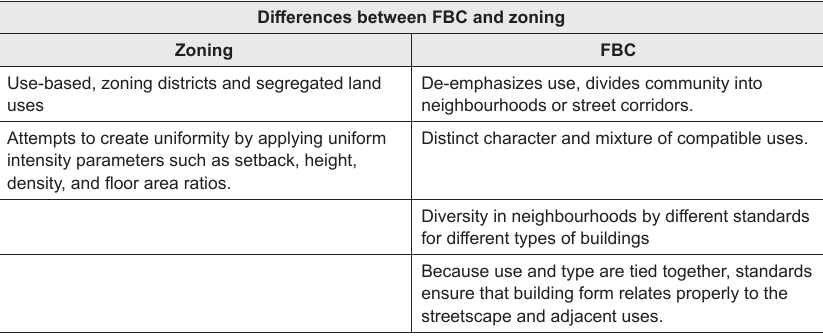
Differences between FBC and conventional zoning approaches